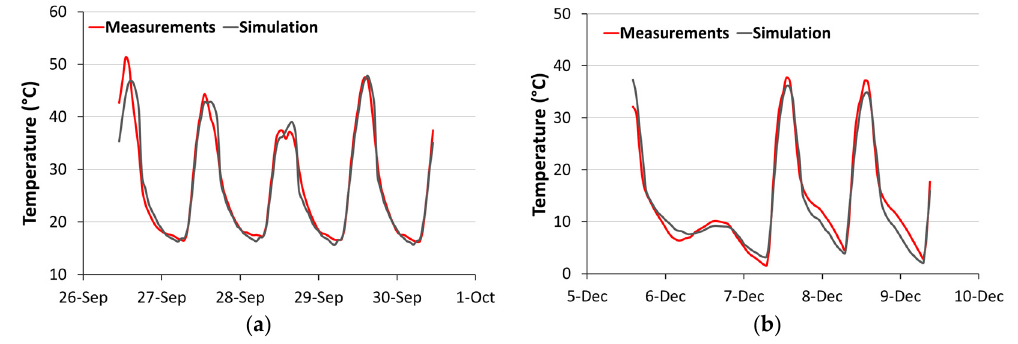
Figure 8. Measured and simulated air temperature, inside the PCM box for the warm season ( a ) and cold season ( b ) monitoring campaign.